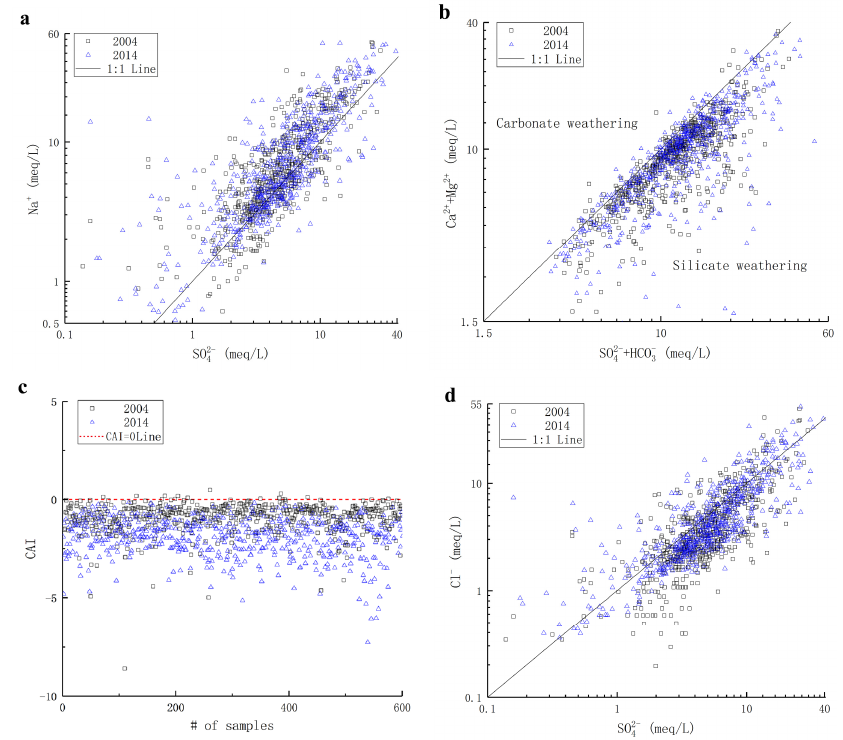
Figure 5. Relationship between hydrochemical composition of groundwater in the study area: ( a ) Na (cid:2878) versus SO (cid:2872)(cid:2870)(cid:2879) ; ( b ) Ca (cid:2870)(cid:2878) + Mg (cid:2870)(cid:2878) versus SO (cid:2872)(cid:2870)(cid:2879) + HCO (cid:2871)(cid:2879) ; ( c ) chloro-alkaline indices (CAI); ( d ) Cl (cid:2879) versus SO (cid:2872)(cid:2870)(cid:2879) .